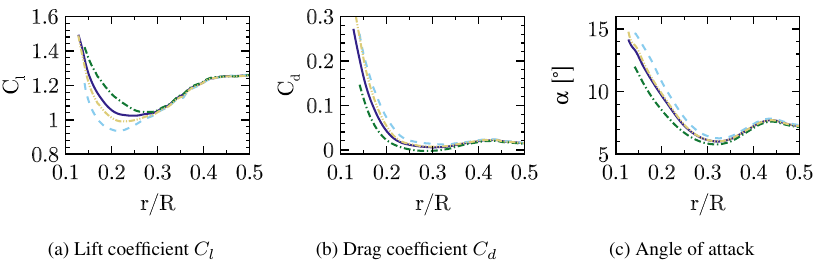
Figure 28. Aerodynamic properties along the blade radius for CaseT1.4 (solid), CaseT1.4-dXm04 (dashed dot dot), CaseT1.4-dYm05 (dashed dot) and CaseT1.4-dYp05 (dashed).